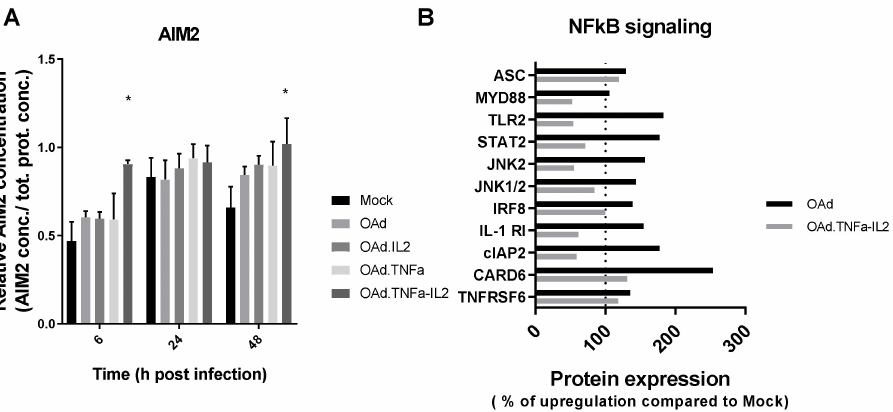
Figure 2. Protein expression measurements: ( A ) The AIM2 protein levels measured from infected (100 VP / cell) SK-MEL-28 cells with indicated viruses at several timepoints by ELISA. Kruskal–Wallis SEM compared to mock, * p = 0.05. ( B ) Infected SK-MEL28 cells were analyzed for NF κ B-related protein expression at 48 h post infection.(p.i.) (100 VP / cell). Kruskal–Wallis SEM compared to mock, * p = 0.05.